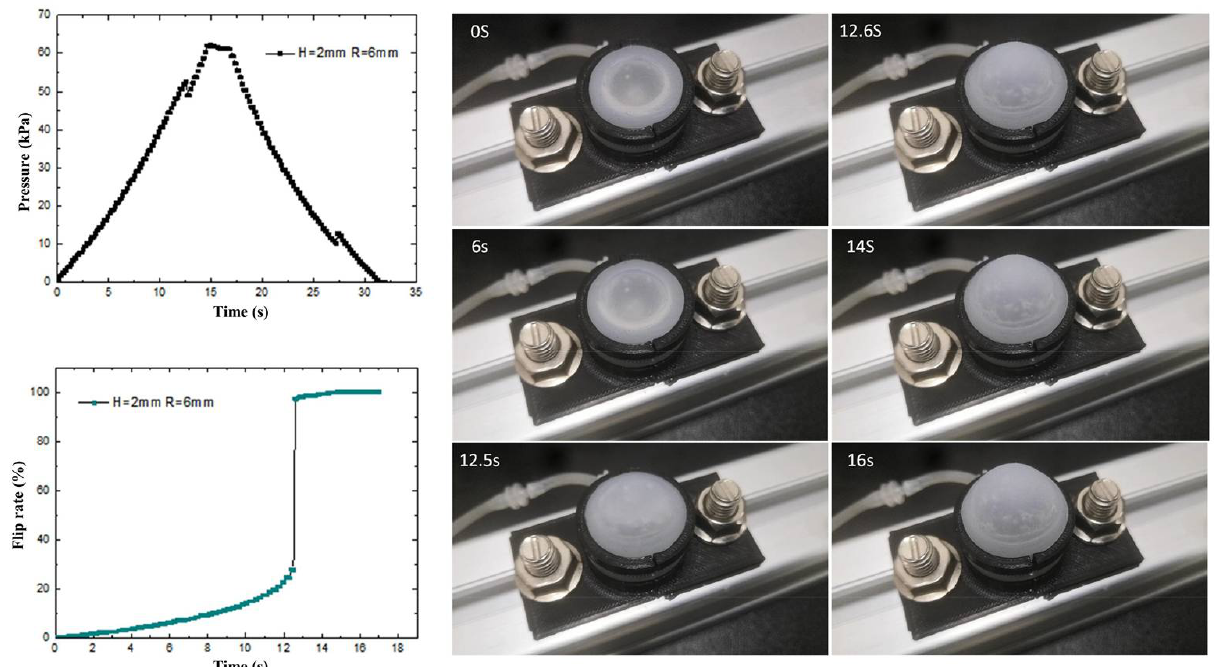
Figure 7. Ball membrane driving process, pressure time variation and loading flip rate curve.